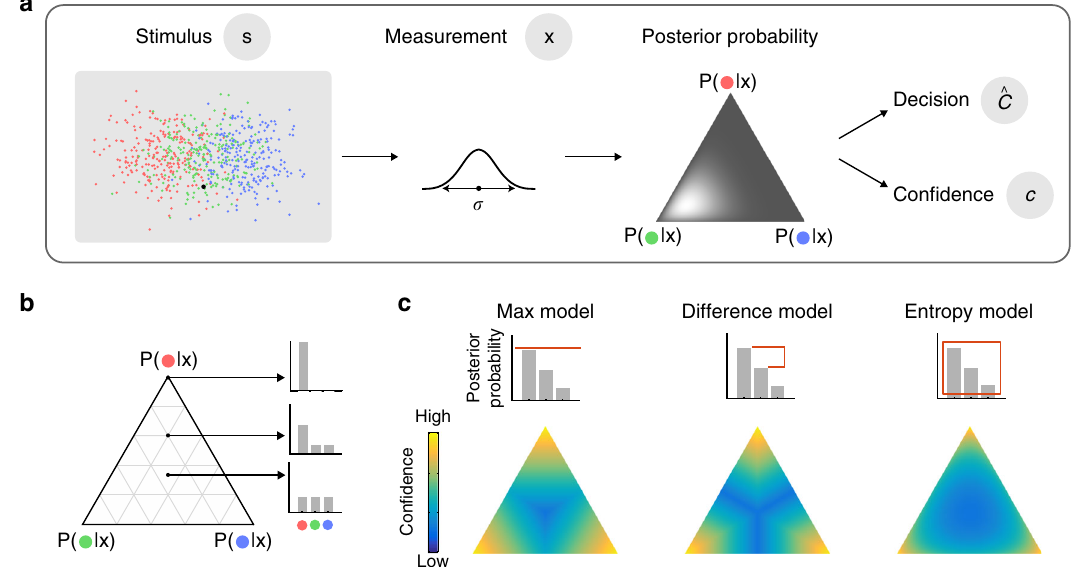
Fig. 2 Models. a Generative model. Target position is represented by s . Two sources of variability are considered in the model: First, observers have access to noisy measurement x , a Gaussian distribution centered at s with a standard deviation σ . Second, given the same measurement x , the posterior distribution varies across trials due to decision noise, modeled by Dirichlet distribution, of which spread (represented by the shade of the ternary plot) is controlled by a parameter α (see Methods). On each trial, a decision ^ C and a con fi dence c are read out from the posterior distribution of that trial. b We use ternary plots to represent all possible posterior distributions. For example, a point at the center represents a uniform posterior distribution; at the corners of the ternary plot, the posterior probability of one category is one while the posterior for the other two categories are zeros. c The bar graphs illustrate how con fi dence is read out from posterior probabilities in each model. For the purposes of these plots, we did not include decision noise here. The color of each ternary plot represents the con fi dence as a function of posterior distribution for each model. The color is scaled for each ternary plot (independently) to take the whole range of the color